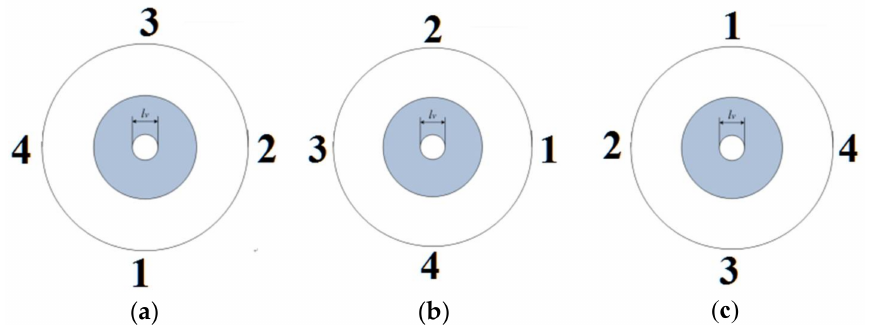
Figure 13. The rotated standard: ( a ) position 1; ( b ) position 2; ( c ) position 3.